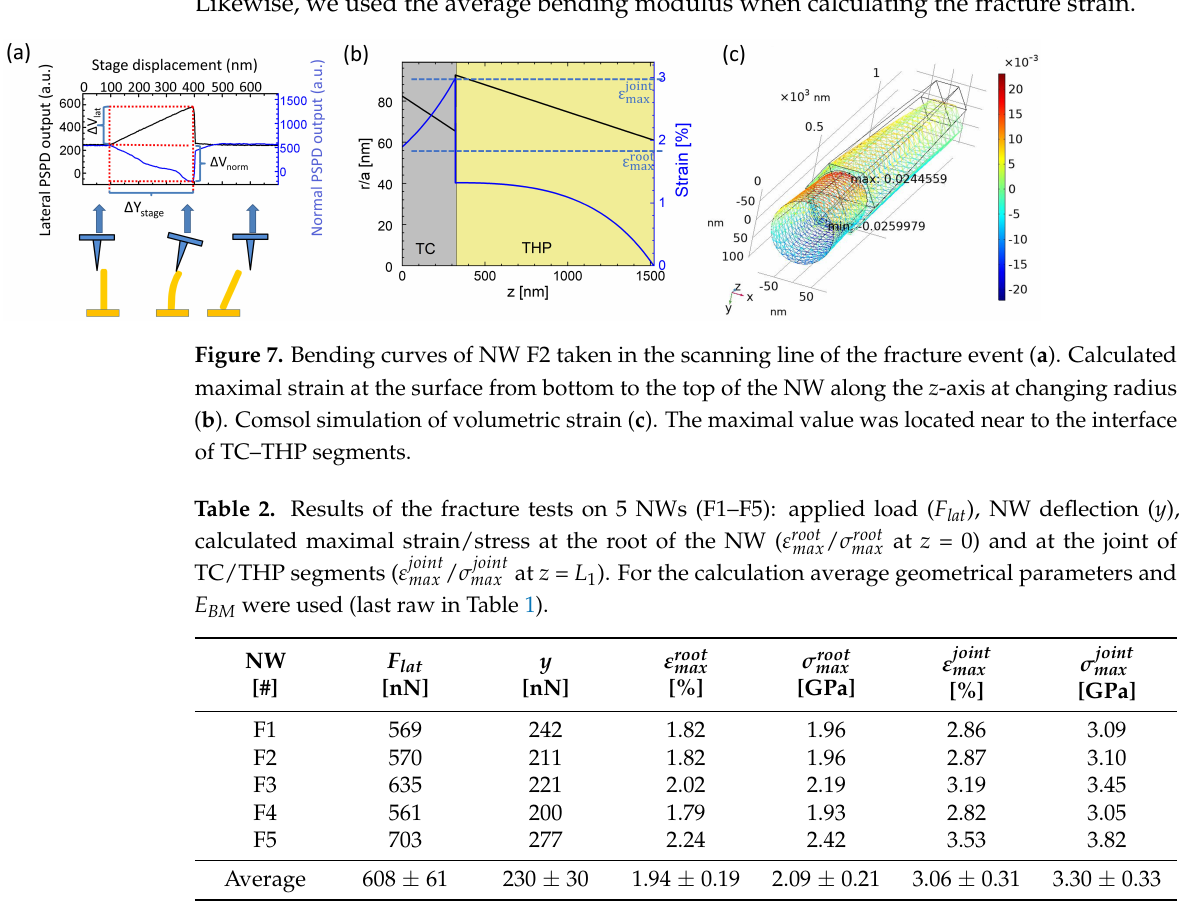
Table 2. Results of the fracture tests on 5 NWs (F1–F5): applied load ( F lat ), NW deflection ( y ), calculated maximal strain/stress at the root of the NW ( 𝜀 (cid:3040)(cid:3028)(cid:3051)(cid:3045)(cid:3042)(cid:3042)(cid:3047) / 𝜎 (cid:3040)(cid:3028)(cid:3051)(cid:3045)(cid:3042)(cid:3042)(cid:3047) at z = 0) and at the joint of TC/THP segments ( 𝜀 (cid:3040)(cid:3028)(cid:3051)(cid:3037)(cid:3042)(cid:3036)(cid:3041)(cid:3047) / 𝜎 (cid:3040)(cid:3028)(cid:3051)(cid:3037)(cid:3042)(cid:3036)(cid:3041)(cid:3047) at z = L 1 ). For the calculation average geometrical parameters and E BM were used (last raw in Table 1).